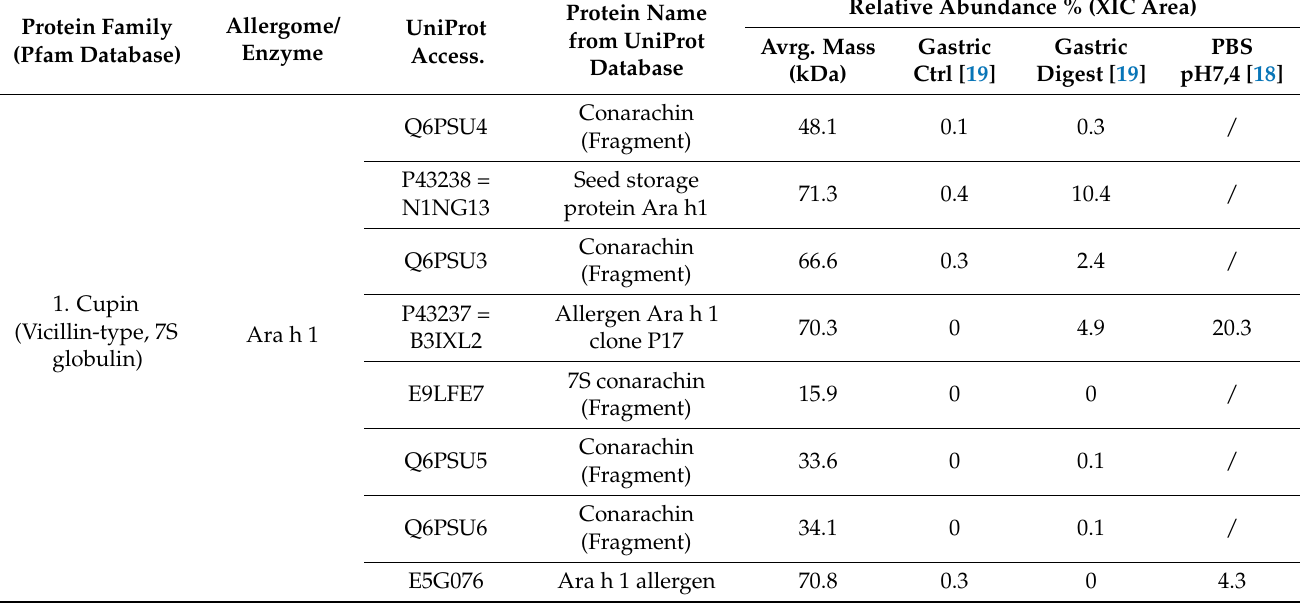
Table 1. Allergens and non-allergenic proteins identified and relatively quantified by proteomics approach in mature peanut seed ( Arachys hypogaea